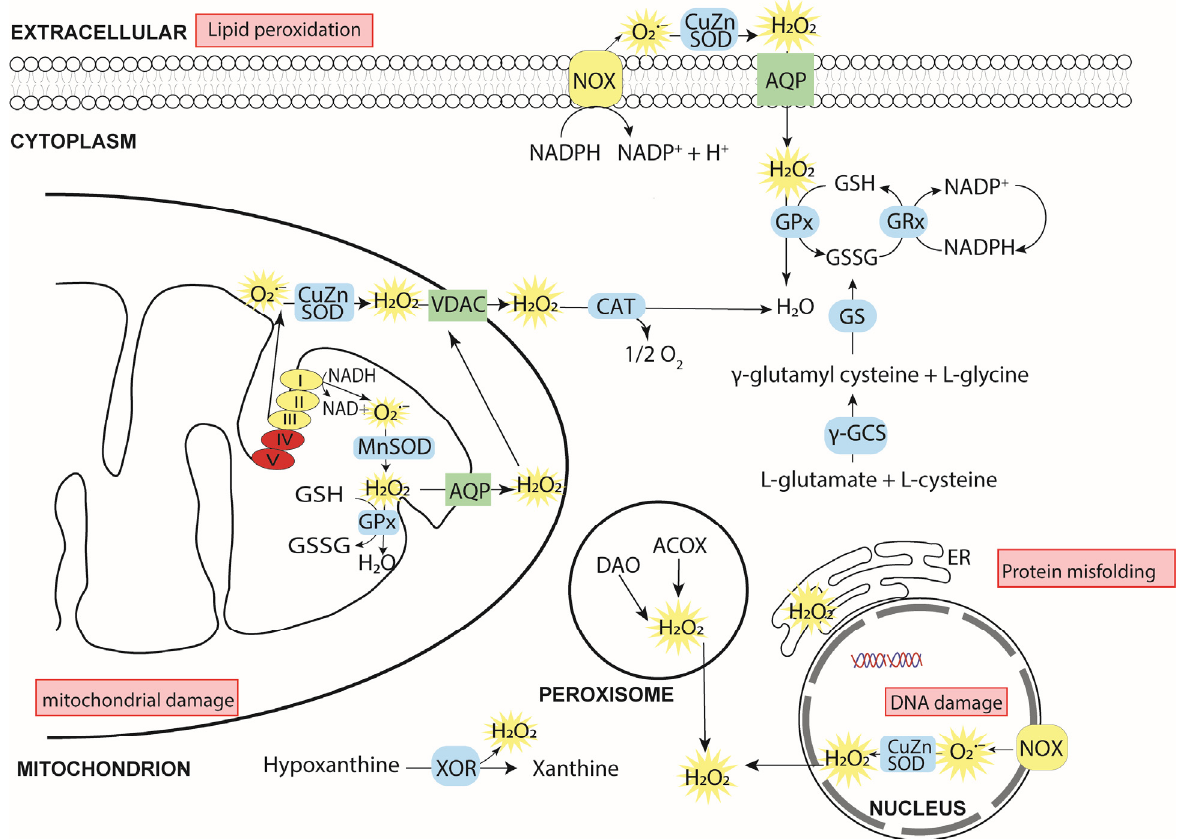
Figure 2. Cellular sources of ROS and antioxidants, and the effects of oxidative distress. Numerous cellular enzymes (yellow discs) produce ROS (shown in yellow sunbursts), whose homeostatic concentrations are controlled by a comprehensive system of antioxidants (only GSH is shown here) and antioxidant enzymes (blue discs) [37] . Principal sources are NOX, Complexes I–III of the mitochondrial electron transport chain due primarily to electron leakage [8,26] , and to various enzymes (not shown), such as proline oxidase, which are coupled to Complex II [8,26] . The principal ROS signalling molecule is H 2 O 2 (physiological concentration ≈ 1–10 nM [8,26] ), which can penetrate membranes directly or (more efficiently) by transmembrane transporters (green disks). Oxidative distress occurs when the antioxidant system cannot maintain homeostatic concentrations of ROS, which can lead to a range of cellular dysfunctions (red boxes), frequently resulting in growth arrest and apoptosis. ACOX, acyl coenzyme A oxidase; AQP, aquaporin; CAT, catalase, CuZnSOD, copper–zinc superoxide dismutase; DAO, diamine oxidase; γ -GCS, γ -glutamylcysteine synthetase; GPx, glutathione peroxidase; GRx, glutathione reductase; GS, glutathione synthetase; MnSOD, manganese superoxide dismutase; NOX, NADPH oxidase; VDAC, voltage-dependent anion channel; XOR, xanthine oxidoreductase.